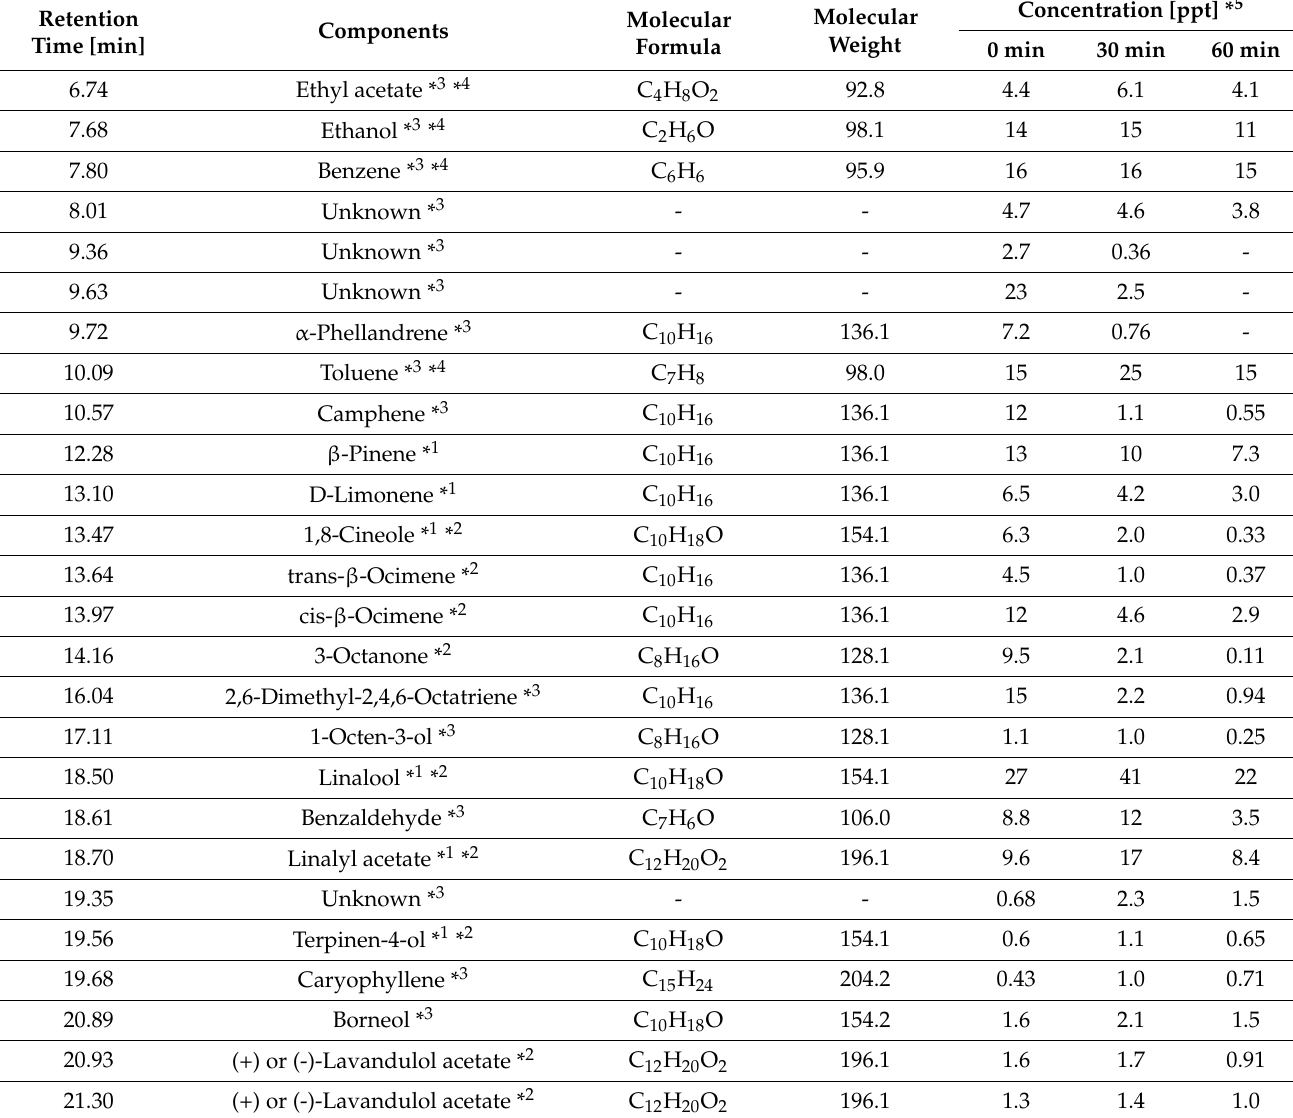
Table 3. The concentration of each component from room air including diffused lavender essential